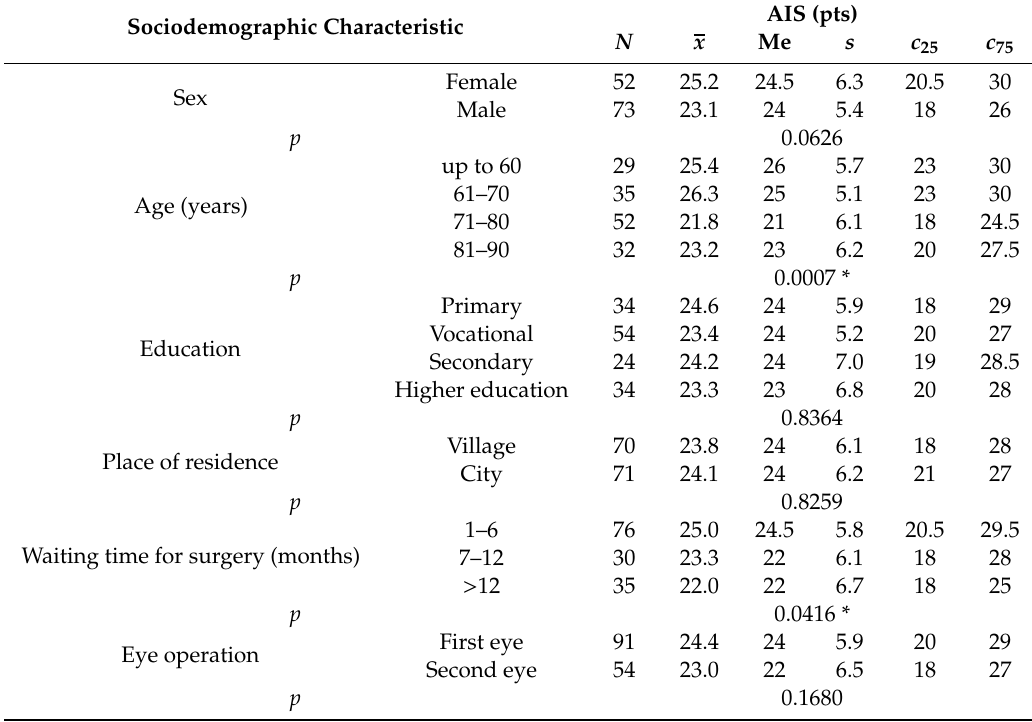
Table 8. E ff ect of selected sociodemographic characteristics on the level of acceptance of illness with reference to numerical values.